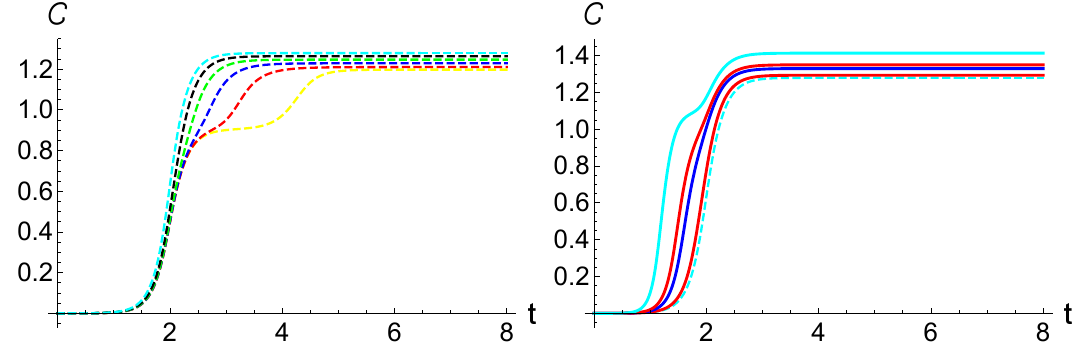
Figure 3 . Complexity display two separate linear growths when the parameters ( (cid:15) 1 , (cid:15) 2 ) for the system and bath oscillators are different. In the left panel the bath parameter (cid:15) and the system parameter (cid:15) is scanning from -1 to -6. Whereas in the right panel, the system 1 parameter (cid:15) is chosen as -6, -7, -10, -12 and -20 from dashed cyan to solid cyan curve 1